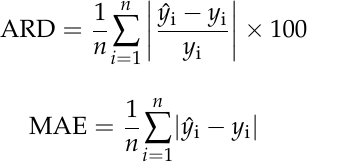
( d ) Figure 6. Comparison of h vap s vap at different temperatures: ( a ) R245fa; ( b ) R600a; ( c ) R134a; ( d ) R1234ze(E).